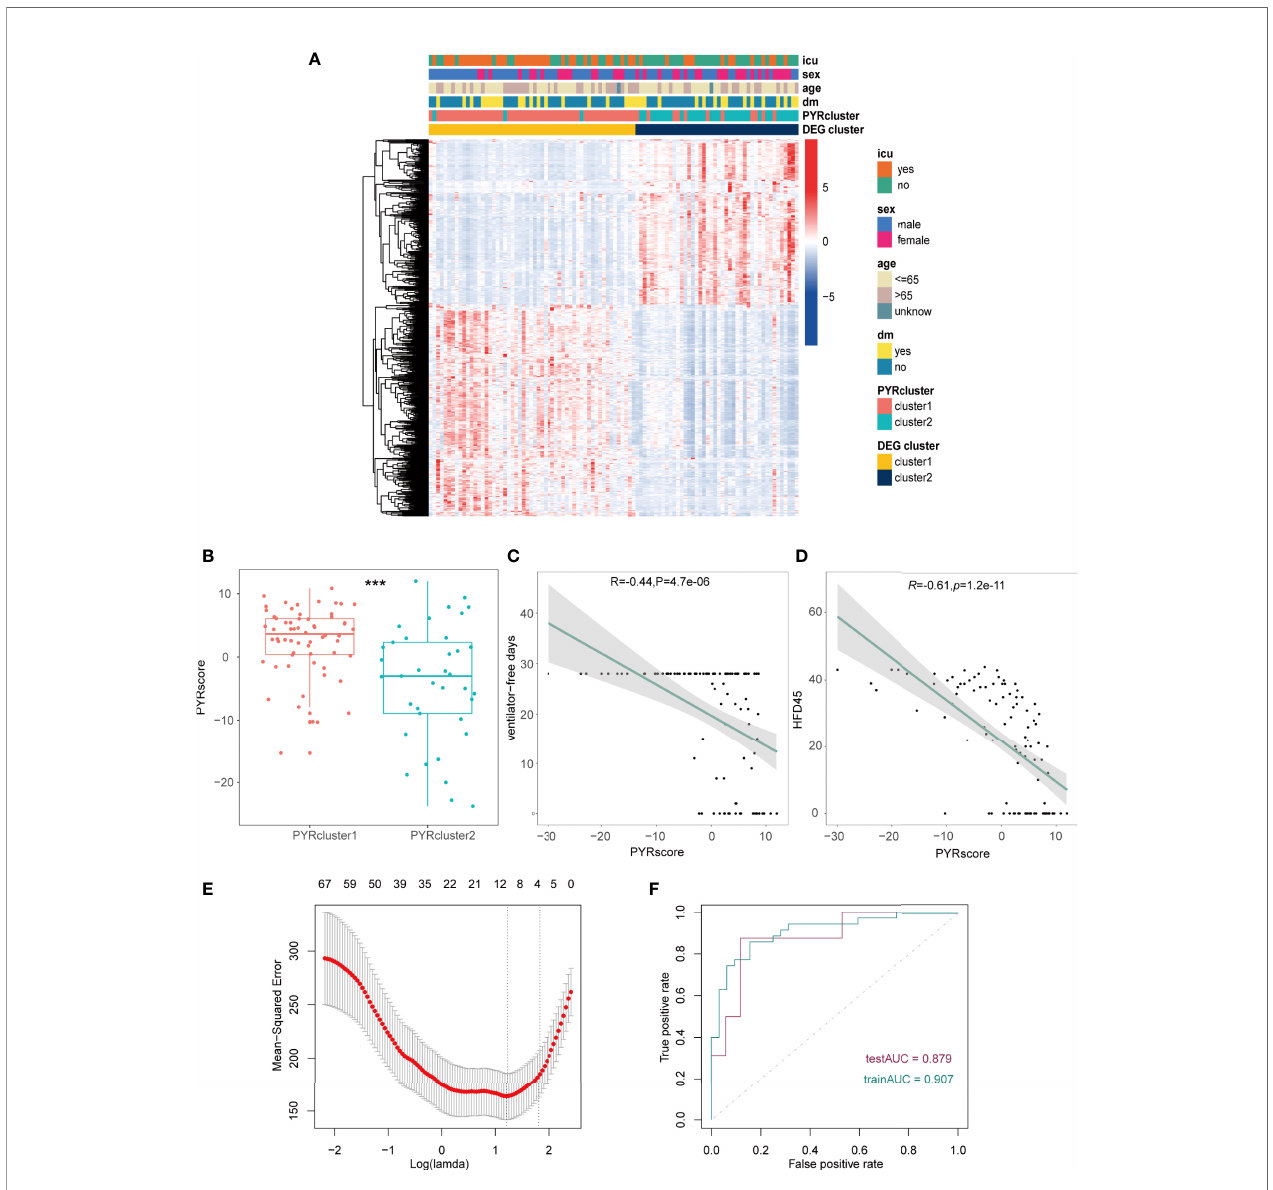
FIGURE 5 | (A) Heatmap of the DEGs between the gene clusters, different clinical data was shown in the annotation. (B) Pyrscore between two PYRclusters. (C, D) Pearson ’ s correlations between pyrscore and ventilator-free days (C) , HFD45 (D) , R value represents the Pearson ’ s correlation coef fi cient; grey area represents the 95% con fi dence interval for the linear fi t. The maximum value of ventilator-free days is 28 since this 28-day time frame was initially chosen because most subjects with ARDS will have died or been extubated by Day 28. (E) Mean-squared error (MSE) of different numbers of variables revealed by the LASSO regression model. The red dots represent the MSE values; the grey lines represent the standard error (SE); the two vertical dotted lines on the left and right, respectively, represent optimal values by minimum criteria and 1-SE criteria. “ Lambda ” is the tuning parameter. (F) AUC of patients in the training group and test group. *p < 0.05, **p < 0.01, ***p < 0.001, ****p < 0.0001, ns, no signi fi PYRsafescore = 0 : 024522643 (cid:2) PEBP 1+0 : 279568268 (cid:2) IL 2 RB +3 : 19881976 (cid:2) HLA − DMB +